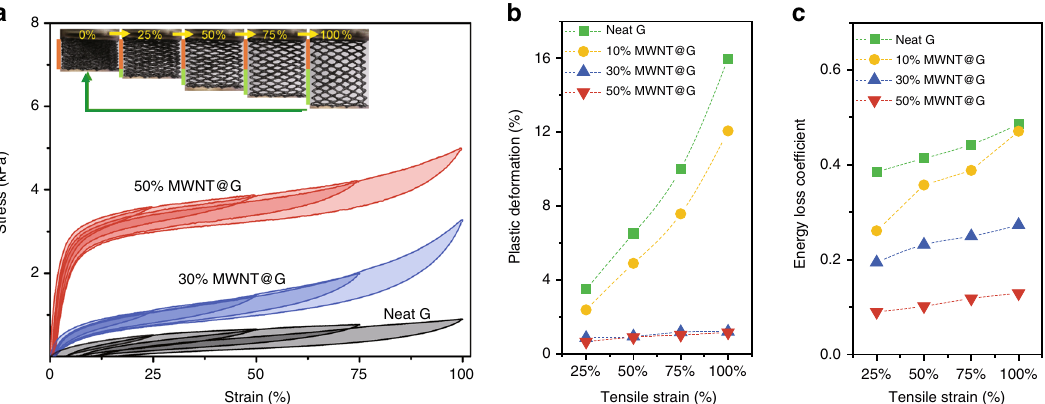
Fig. 2 Uniaxial monotonic tensile tests. a Stress-strain curves of bCAs with increasing dose of MWNTs at 25, 50, 75, and 100% tensile strains. b , c Plastic deformation and energy loss coef fi cient corresponding to different stains in a